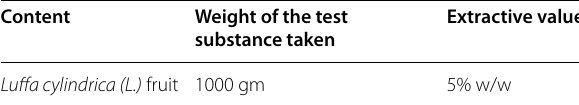
Table 1 Extractive value of the plant extract Content Weight of the test Extractive value substance taken Luffa cylindrica (L.) fruit 1000 gm 5% w/w